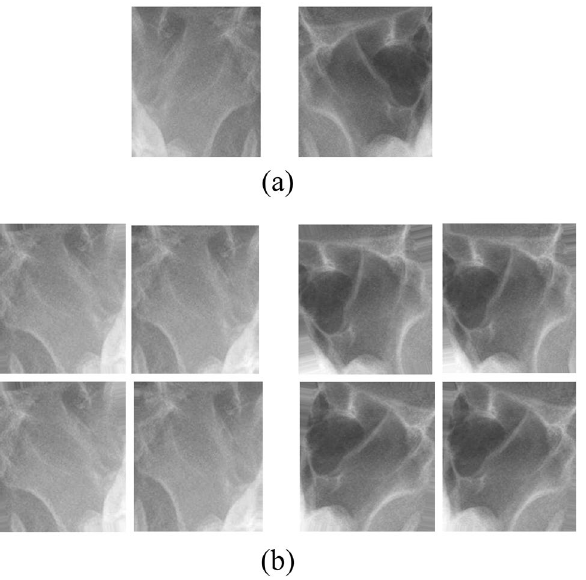
Figure 7. Samples of conventional data augmentation. ( a ) Horizontal flip. ( b ) Random rotation (− 10 to